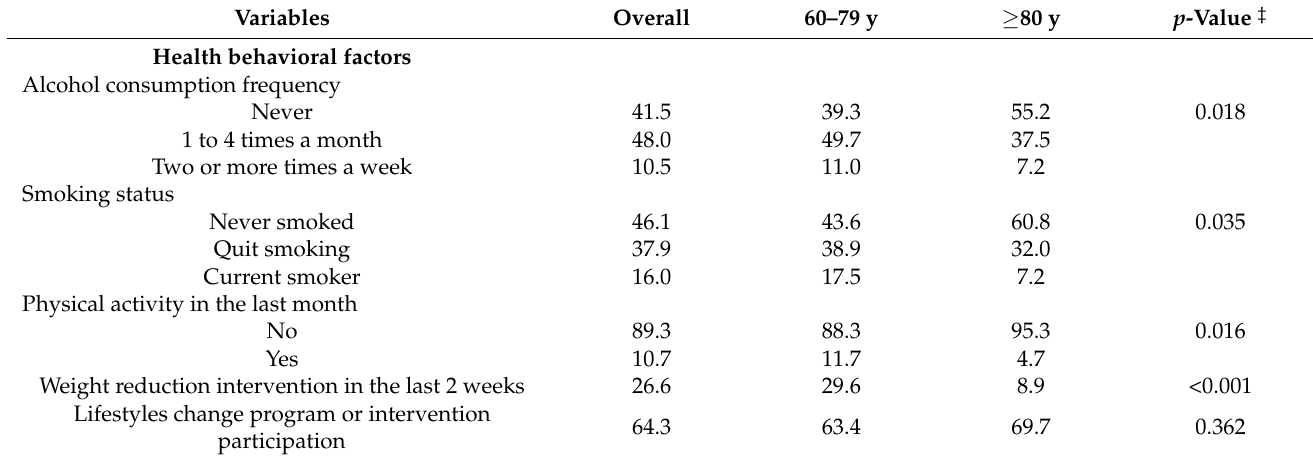
Table 2. Description of health behavioral and dietary factors of the sample by age